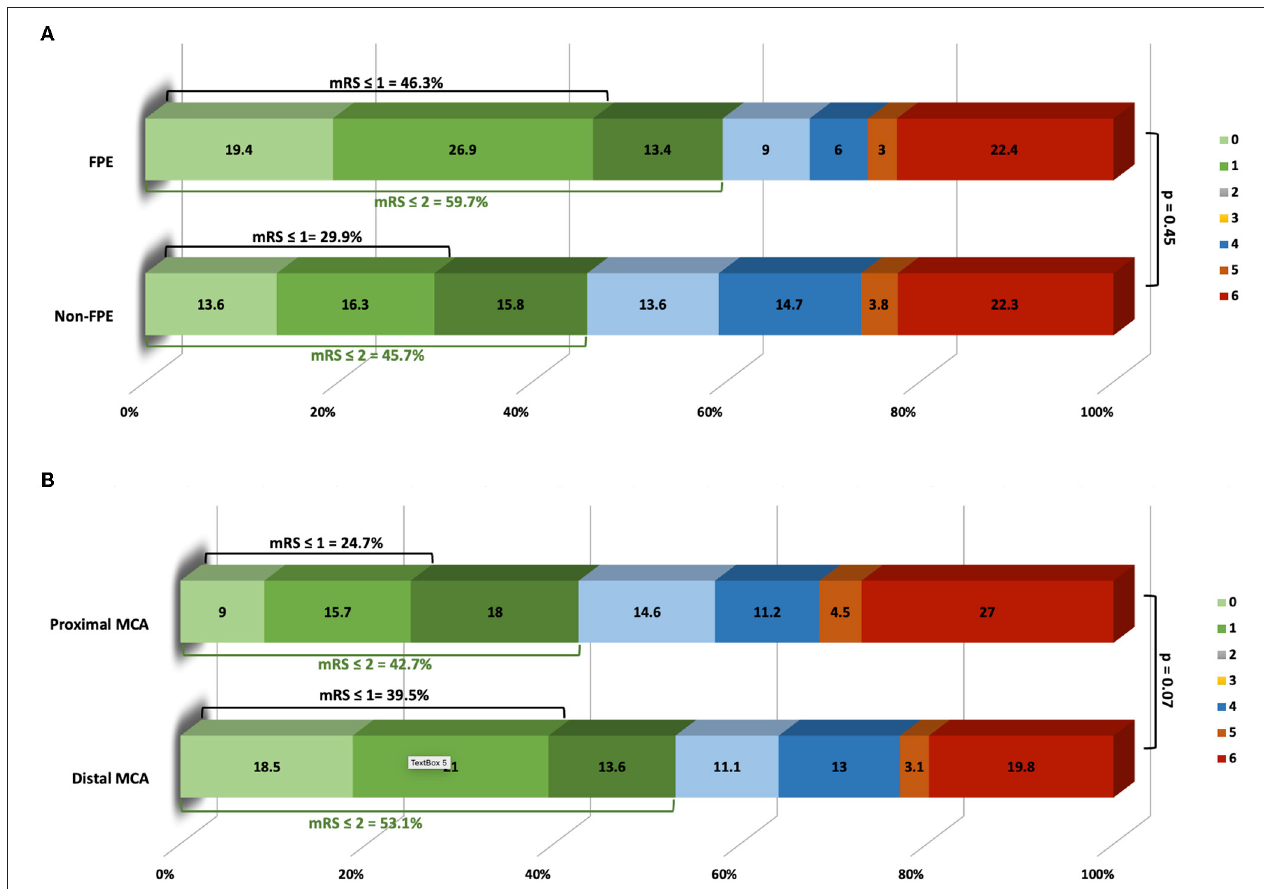
FIGURE 2 | (A) Modified Rankin Scale of patients with first pass effect and no first pass effect at 3 months. (B) Modified Rankin Scale of patients with proximal or distal middle cerebral artery occlusions at 3 months.